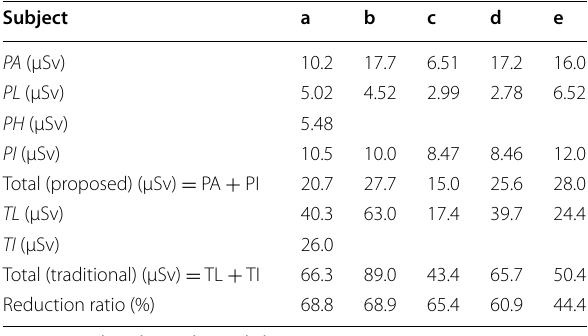
Table 2 Experimental results